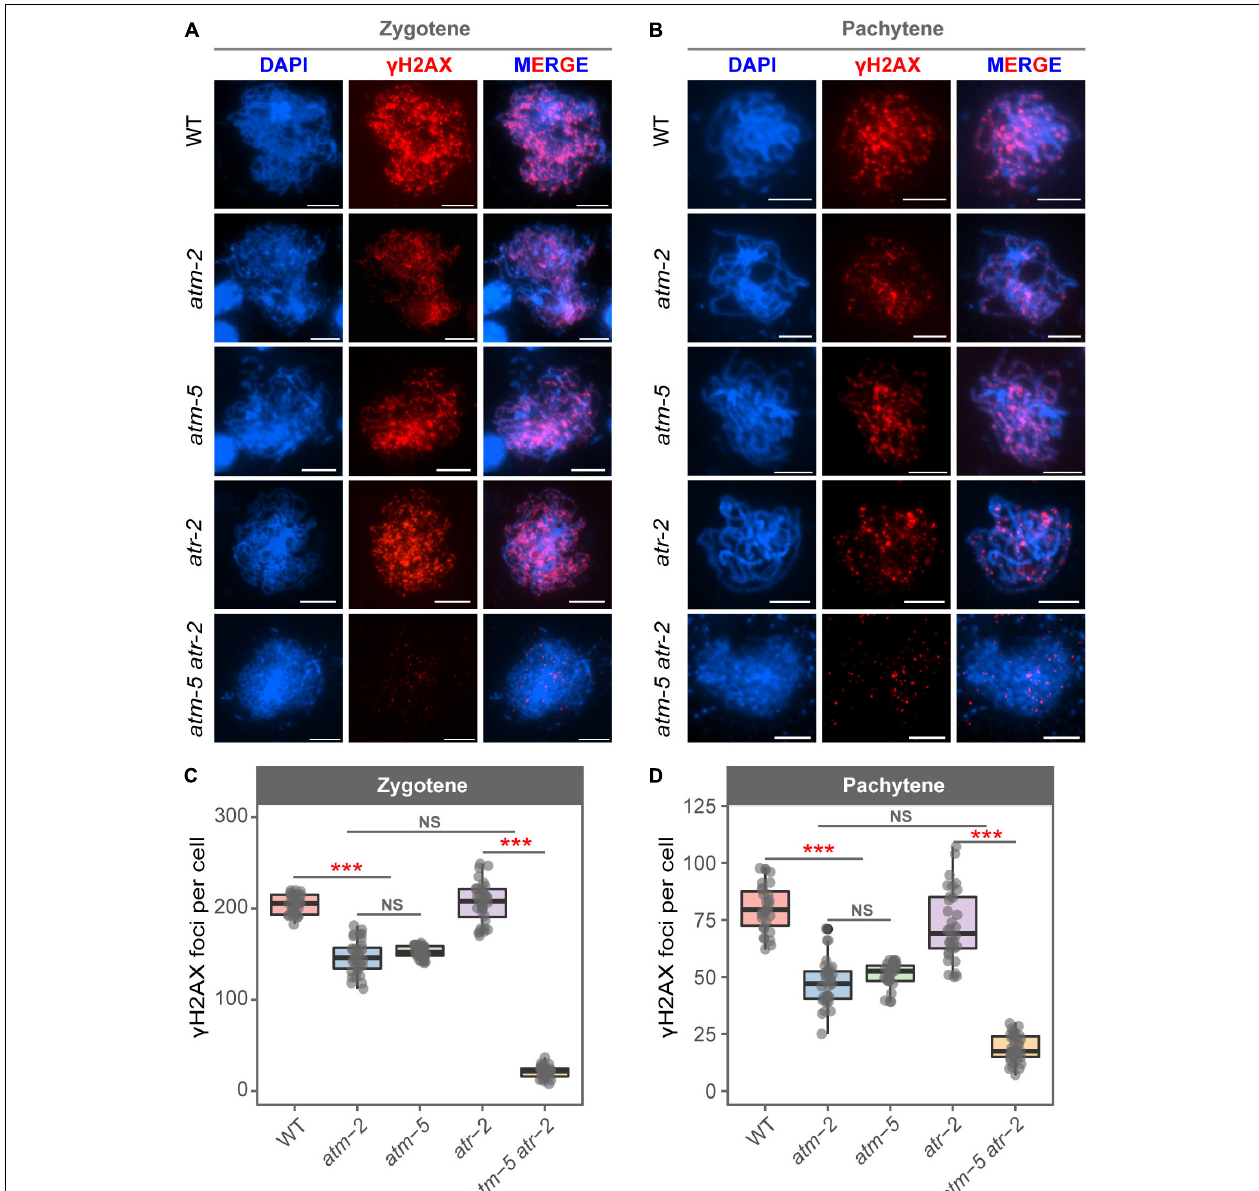
FIGURE 3 | Immunolocalization of γ H2AX in male meiocytes of different alleles. (A) γ H2AX localization on zygotene stage chromosomes of wild type, atm-2 , atm-5 , atr-2, and atm-5 atr-2 respectively. (B) γ H2AX localization on pachytene stage chromosomes of wild type, atm-2 , atm-5 , atr-2, and atm-5 atr-2 respectively. (C) Number of γ H2AX foci per cell in zygotene stage in different alleles: wild type (204.07 ± 10.64, n = 30), atm-2 (146.84 ± 18.55, n = 32, P = 1.40E-11), atm-5 (152.3 ± 6.59, n = 30, P = 2.91E-11), atr-2 (208.48 ± 24.83, n = 33, P = 4.36E-1) and atm-5 atr-2 (21.1 ± 6.58, n = 29, P = 4.31E-11). (D) Number of γ H2AX foci per cell in pachytene stage in different alleles: wild type (80.2 ± 10.31, n = 30), atm-2 (47.31 ± 10.02, n = 31, P = 6.27E-11), atm-5 (51.07 ± 5.33, n = 30, P = 2.93E-11), atr-2 (72.44 ± 15.66, n = 33, P = 1.86E-2) and atm-5 atr-2 (18.64 ± 5.86, n = 36, P = 3.64E-12). Bar = 5 µ m. NS: P > 0.05, *** P < 0.001 (Wilcoxon Rank Sum test). Cells counted in each allele are from at least 30 plants. The atm-2 and atm-5 are two independent atm mutant alleles.